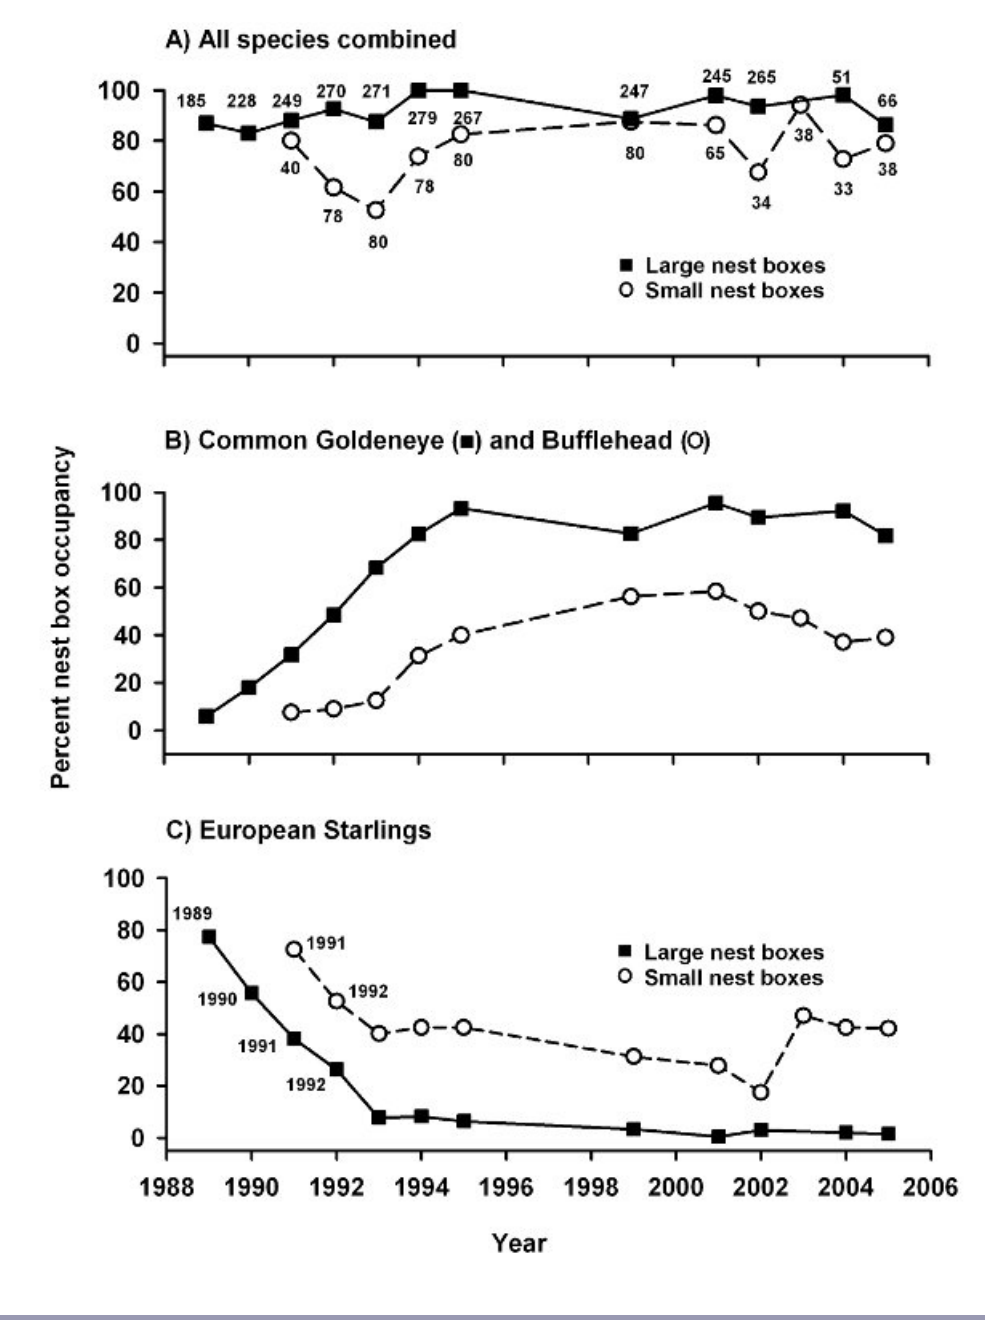
Fig. 2. Temporal patterns in percent occupancy of small and large nest boxes by all species combined (A), Common Goldeneye, Bucephala clangula , and Bufflehead, Bucephala albeola (B), and European starlings, Sturnus vulgaris (C) in the Buffalo Lake Moraine between 1989 to 2005 in central Alberta. Numbers in plot A reflect numbers of nest boxes, whereas numbers in plot C reflect initial study years when occupancy by European Starlings was